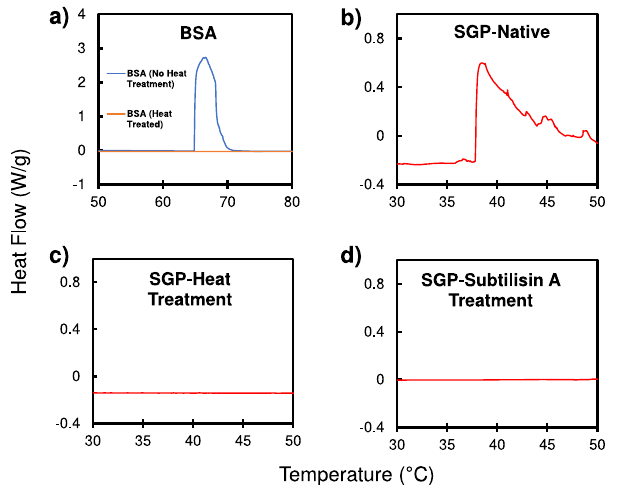
Fig. 7 Protein denaturation identi fi ed via DSC. DSC thermograph of a BSA (10% solution) native (blue line) and heat treatment (orange line) available as reference/standard, SGP solutions (1 – 2 mg/mL) with b no treatment, c heat treatment (70 °C for 60 min), and d subtilisin treatment (1 mg subtilisin/mL) at a heating rate of 0.5 °C/min (red lines). Fig. 8 Protein denaturation via enzyme interaction identi